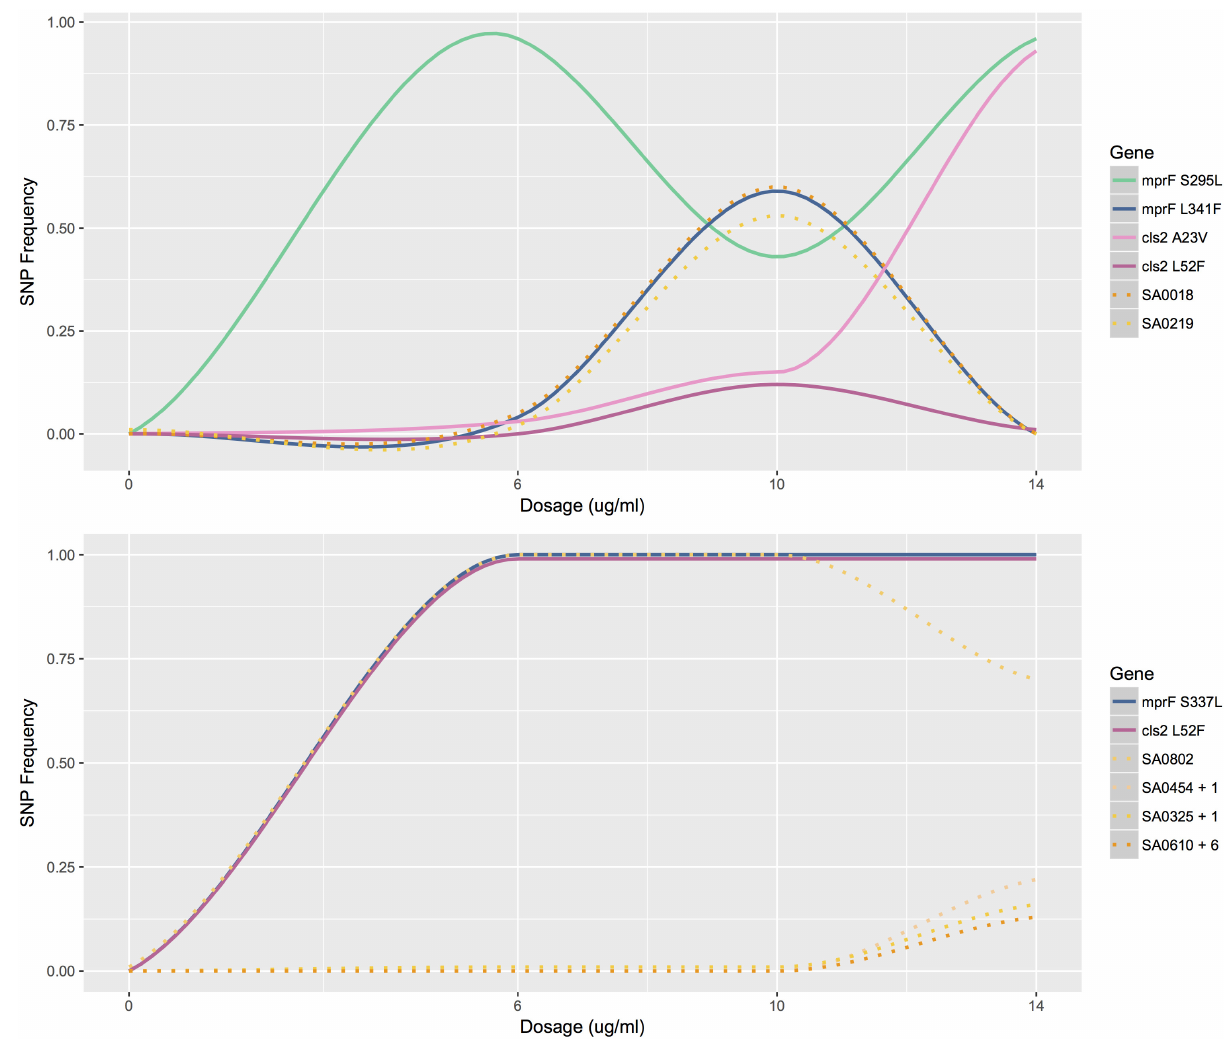
FIGURE 2 | Mutation profiles of populations B and C. The frequency of mutations as a function of antibiotic concentration for population B (top) and C (bottom). Mutations profiled are SNPs that lead to amino acid changes in MprF and Cls2. Other mutations profiled are listed by gene name. SA0454 + 1 represents the similar mutation profiles of SA0454 and SA0613; SA0325 + 1 represents the similar mutation profiles of SA0325 and SA0897; SA0610 + 6 represents the similar mutation profiles of SA0610, SA2134, SA1228, SA_RS07380, SA2023, and